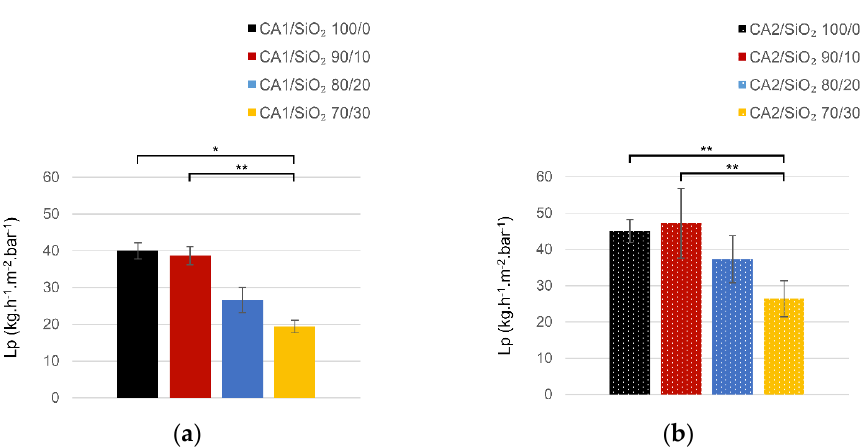
Figure 9. Hydraulic permeability Lp values (kg·h − 1 ·m − 2 bar − 1 ) in ( a ) series one and ( b ) series two (* p < 0.01; ** p < 0.05.